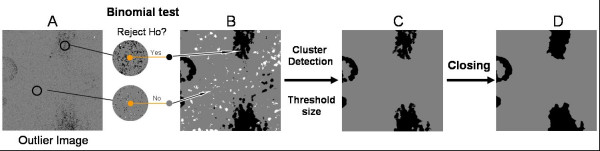
Algorithm to detect areas with diffuse defects. The Outlier Image is obtained as for the analysis of the compact defects. A circular kernel is then applied to each pixel in the image to detect areas in which the observed number of outliers exceeds the expected number, based on a binomial test. The defected areas thus determined undergo a round of cluster detection and size threshold, in order to eliminate small areas. The final step involves a dilation and erosion of the defects, in order to better outline the areas.